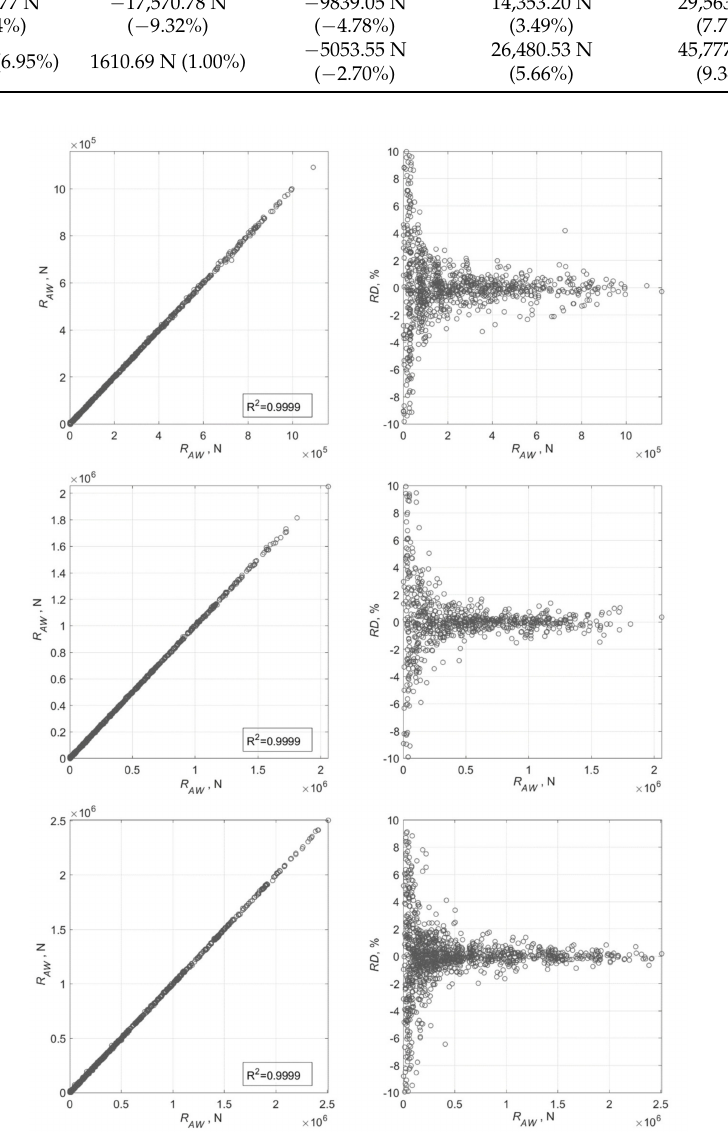
Figure 14. The regression plot ( left ) and RD ( right ) of the data used for testing of ANN with LM and BR with 65 neurons in the hidden layer for the first ( upper ), second ( middle ), and third classes ( lower